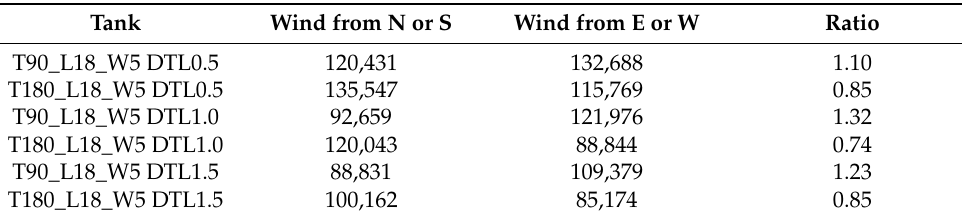
Table 5. Maximum OER (ouE/s) calculated for different wind directions. Tank Wind from N or S